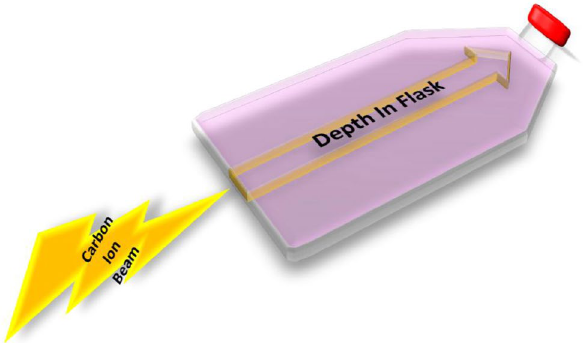
Figure 6. Illistration of carbon-ion beam entry. Prior to irradiation, cell culture flasks were placed upright with the capped end opposite to the beam source. Flasks were irradiated independently from each other and